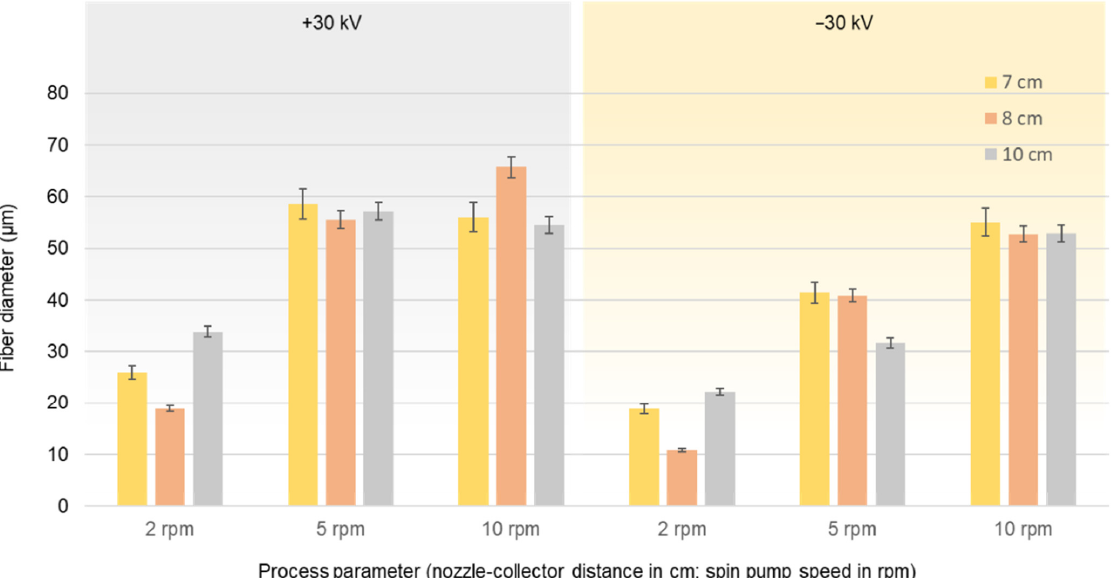
Figure 7. Diameter of PBS fibers produced using pilot-scale melt-electrospinning equipment at a spinneret temperature of 235 °C, a spin pump speed of 2, 5, or 10 rpm, a nozzle-to collector distance of 7, 8, or 10 cm, 600 nozzles (diameter 0.6 mm each), and an electric field strength of +30 or − 30 kV. Data are means ± standard deviation ( n = 100).